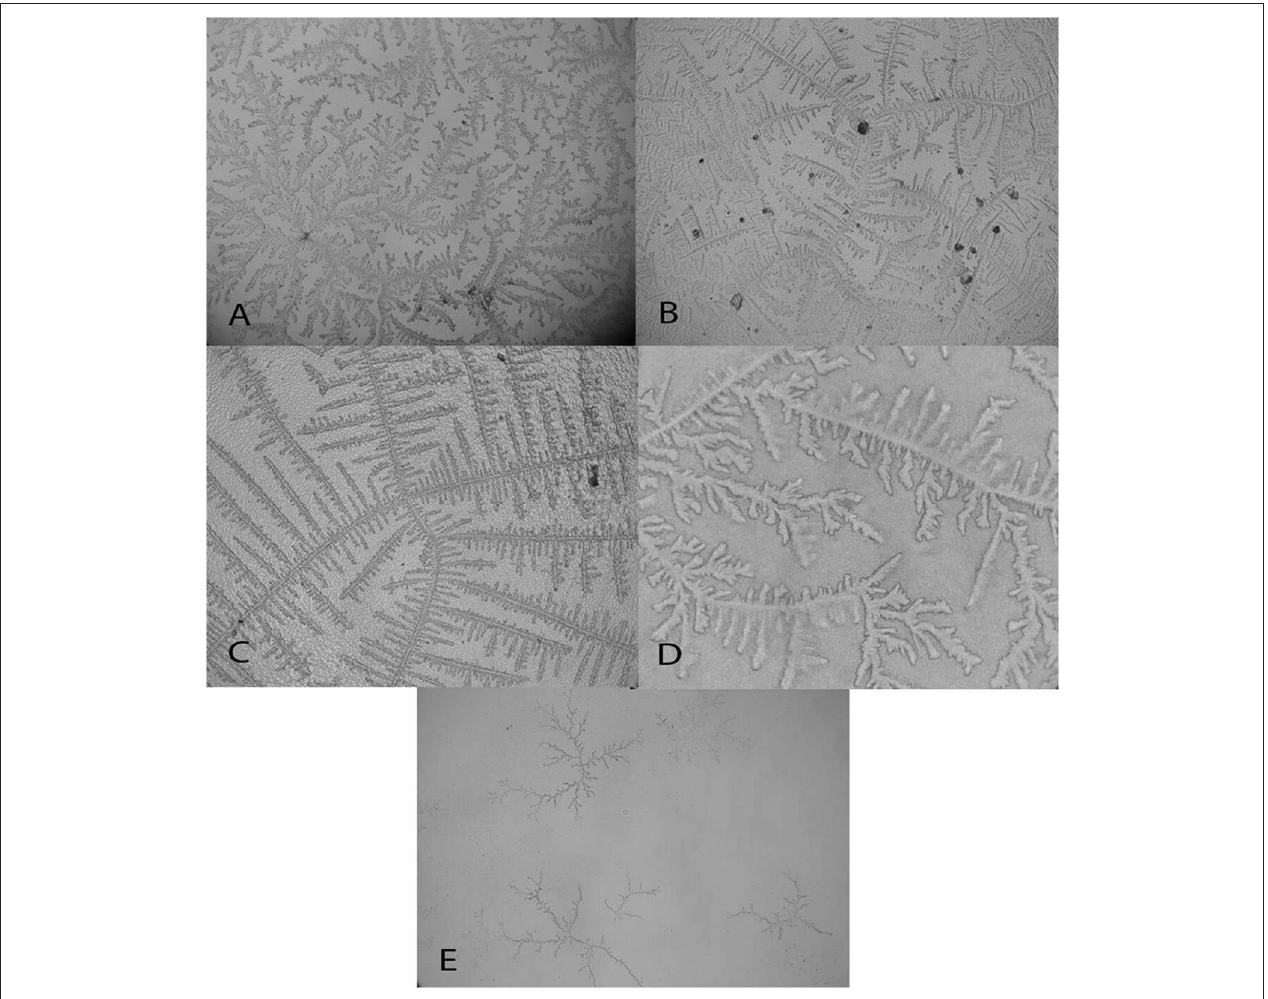
FIGURE 11 | Examples of Caiman latirostris tear ferning patterns, according to the Rolando and Masmali grading scales. (A) Type II (Rolando scale), grading 1 (Masmali scale); (B) Type II (Rolando scale); (C) Type II (Rolando scale), grading 2 (Masmali scale); (D) Type III (Rolando scale), grading 3 (Masmali scale); (E) Type IV (Rolando scale), grading 4 (Masmali